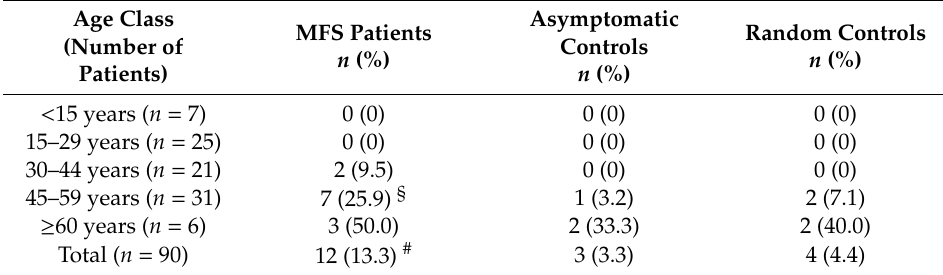
Table 2. Sonographic prevalence of diverticula in patients with MFS and the controls.